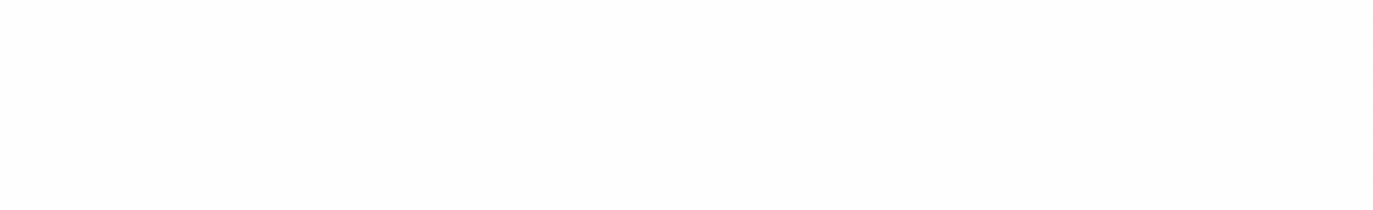
FIGURE 3 The solid line shows the partial maxima Mcal,i(oz (Eq. 8) for the case shown in the left panel of Figure 2. The dashed line represents the case shown in the right panel of Figure